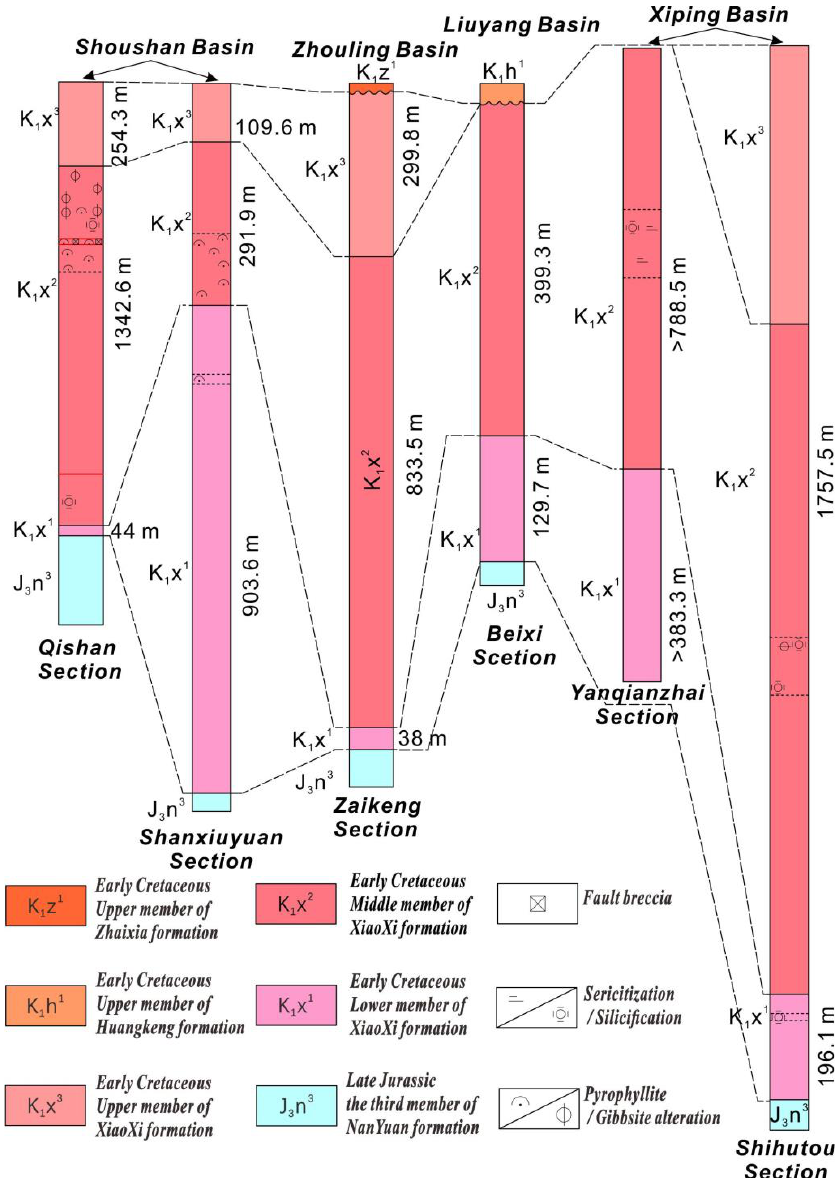
Figure 7. Stratigraphic correlation of Xiaoxi Formation among the sections of typical volcanic basins in Fujian